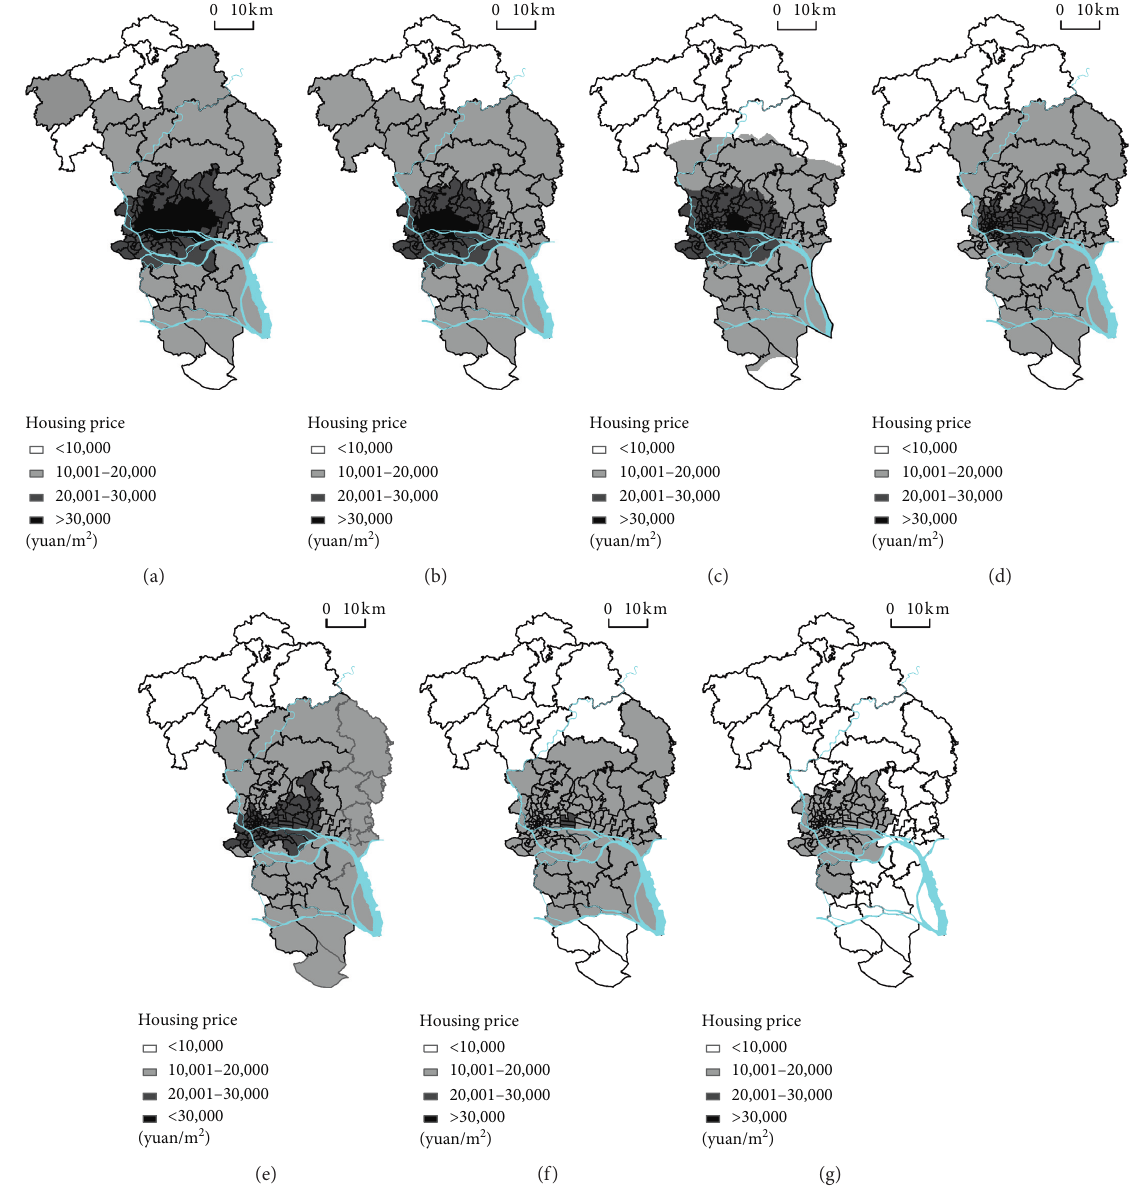
Figure 3: Spatial and temporal evolution of housing price in 2009–2015. (a) 2015. (b) 2014. (c) 2013. (d) 2012. (e) 2011. (f) 2010. (g)